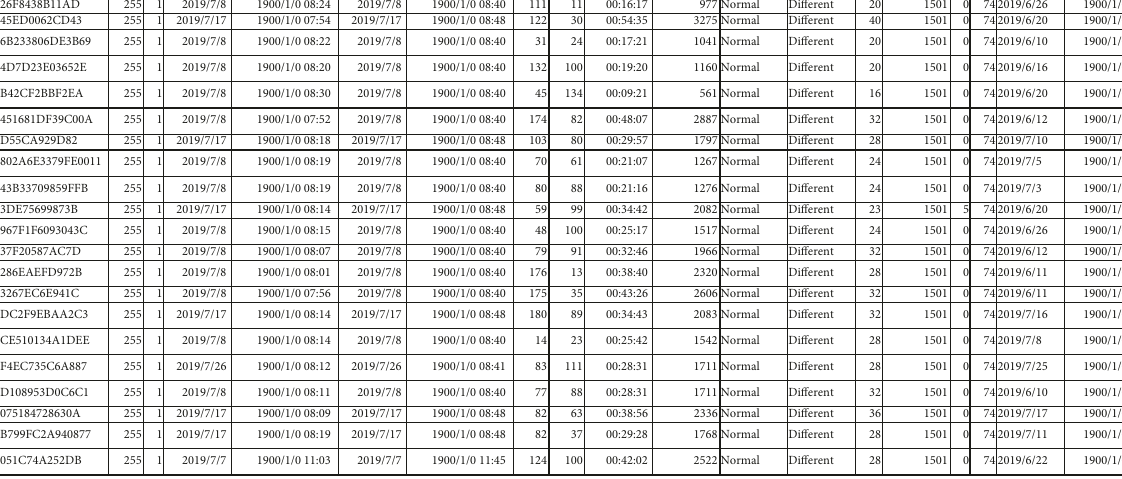
Figure 3: An example of raw data for MRT